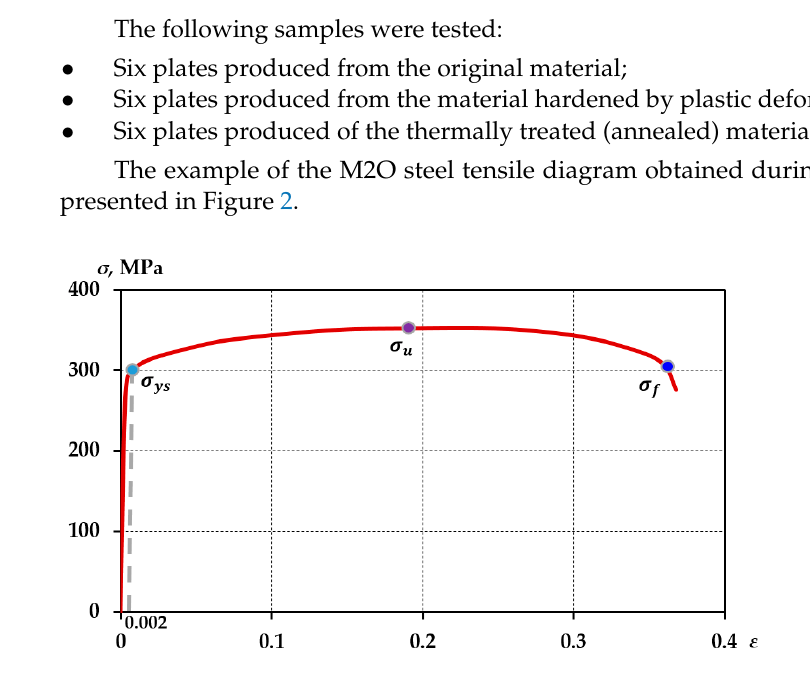
Figure 2. Single uniaxial tensile deformation diagram of steel M2O.